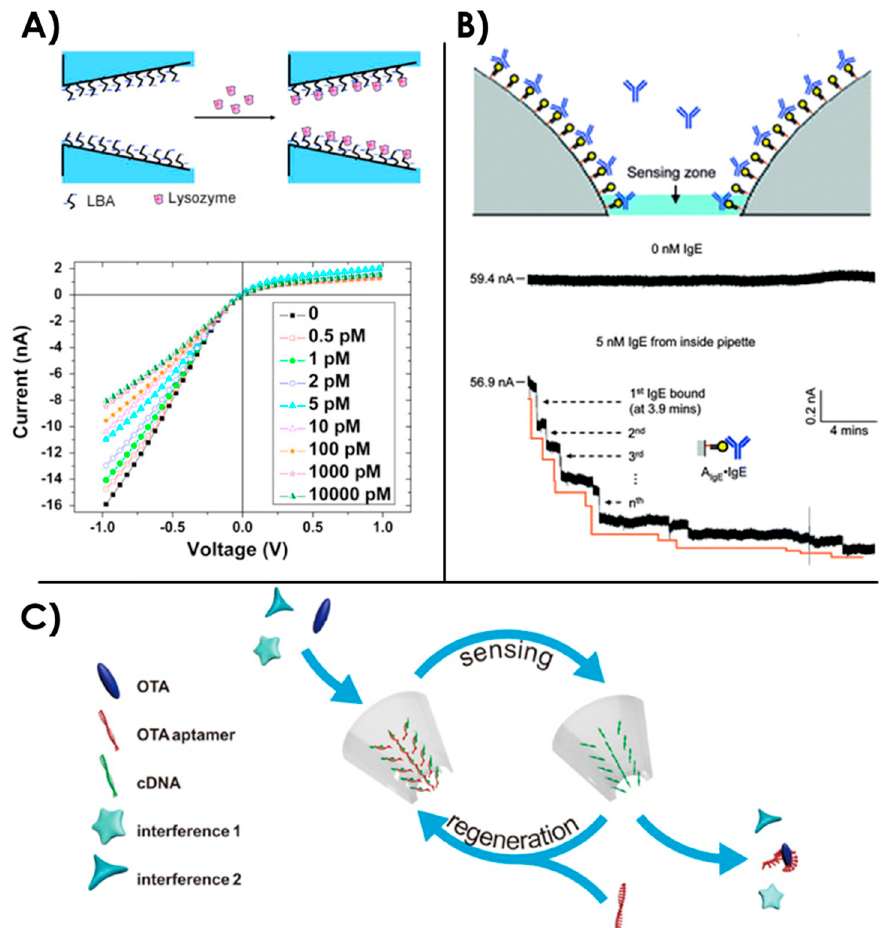
Figure 7. ( A ) Illustration of lysozyme binding aptamer grafting on a 20 nm conical glass nanopores and induced ICR after addition of various concentrations of lysozyme protein [185]. ( B ) Consecutive current decrease steps with immunoglobulin binding on the surface aptamers from reference Reprinted adapted with permission from [108]. Copyright 2009 American Chemical Society. ( C ) Strategy for OTA toxin detection with DNA direct immobilization of aptamers from reference